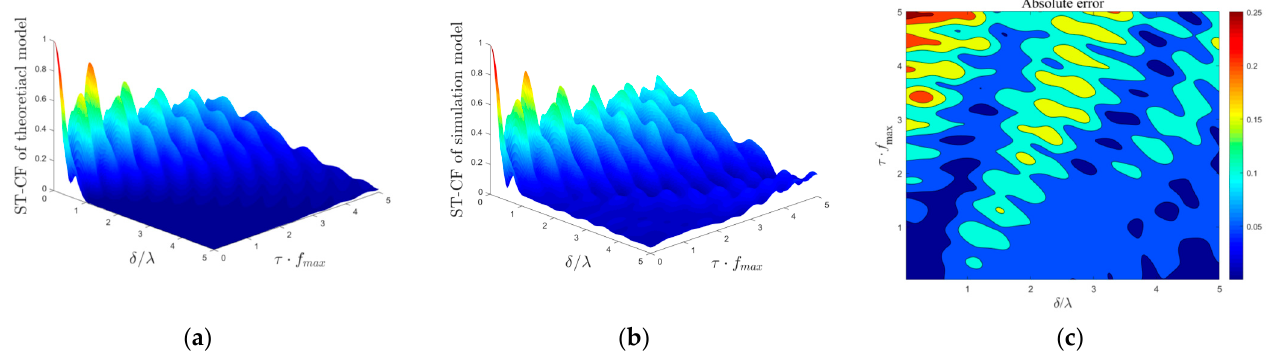
Figure 11. ( a ) ST-CFs of theoretical model in a non-isotropic scattering environment, ( b ) ST-CFs of simulation model in a non-isotropic scattering environment, and ( c ) the corresponding absolute error between ( a ) and ( b ).